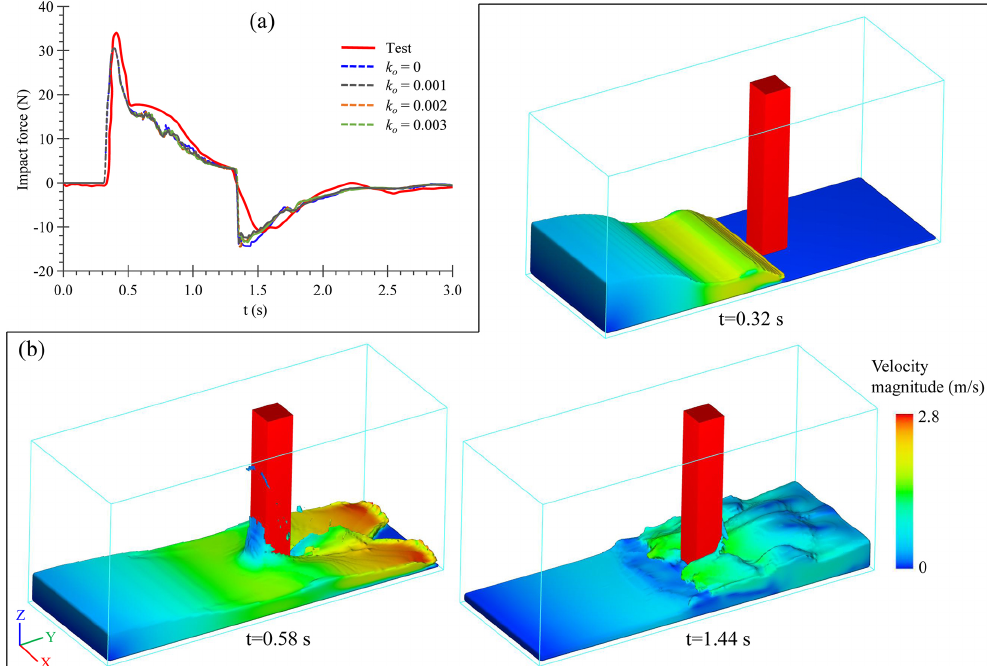
Figure 2. The dam-break simulation (a) comparison between numerical (dotted lines) and experimental values (red line) of the force exerted on the structure. (b) Wave evolution: ( t = 0.32s) the wave is colliding with the front of the obstacle; ( t = 0.58s) the wave is wrapping around the structure, colliding together and continues moving toward the tank wall; and ( t = 1.44s) the reflected wave is hitting the back of the obstacle.